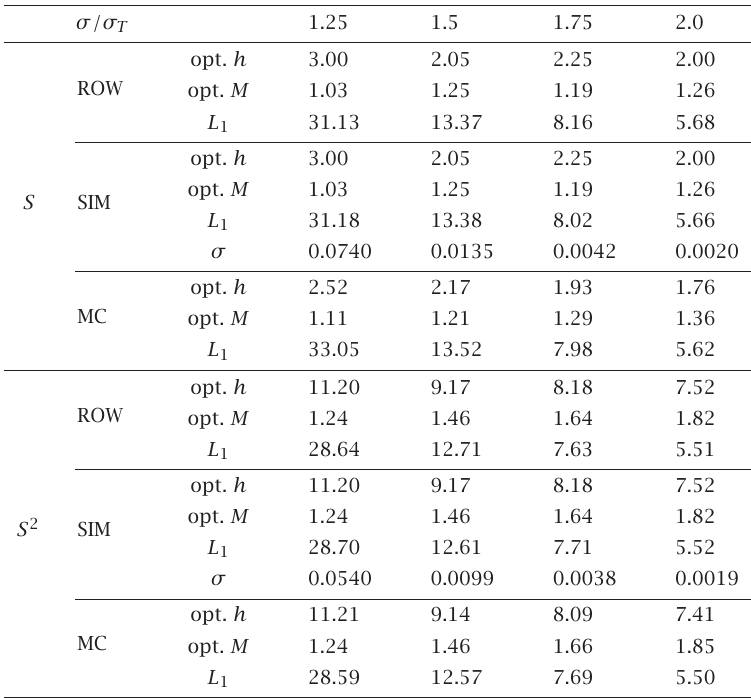
Table 1.1 . Comparisons of the ARL profile of Cusum using Rowlands’ method (ROW), Markov chain approach (MC), and simulation (SIM) for sam- ple size n = 2. The control statistics S and S 2 are used. The in control ARL is